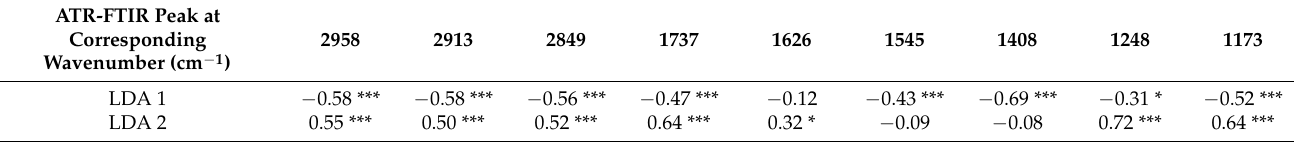
Table 2. Correlation between LDA scores for the first two LDA axes and absorption peaks for distinguished key ATR-FTIR ranges using Spearman rank correlation